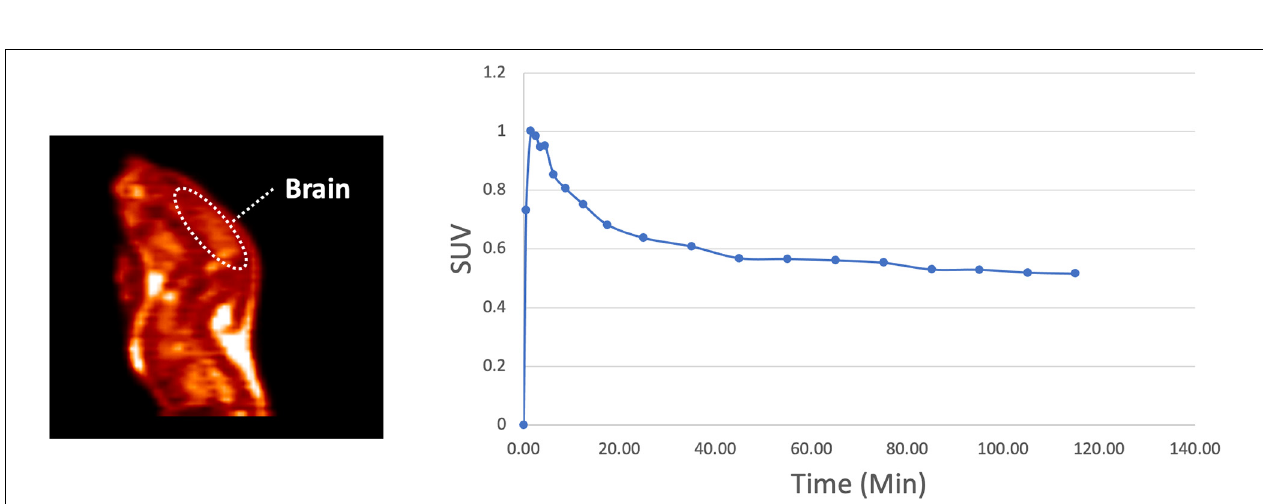
FIGURE 4 | Representative rodent PET imaging with [ 18 F]1 : summed sagittal image (0–120 min post i.v. injection of the radioligand) and average whole brain time-radioactivity curve ( n = 3).